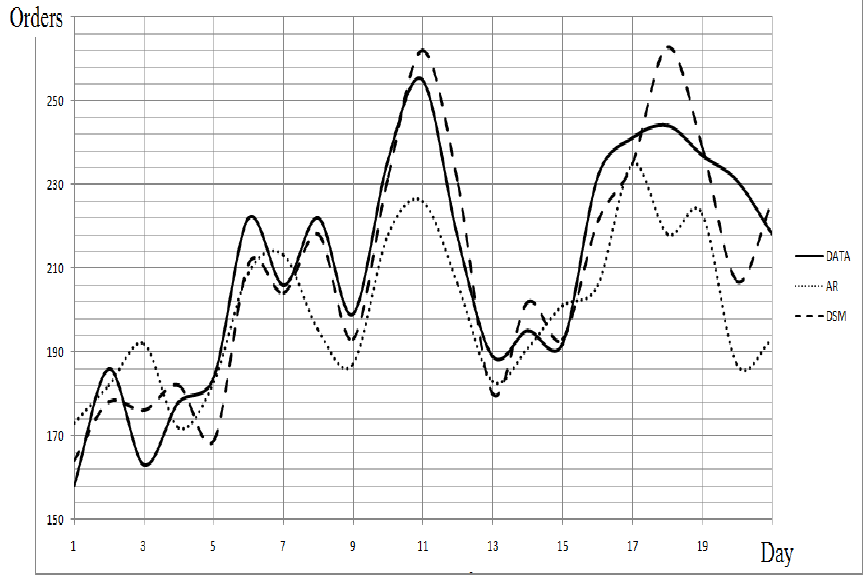
Fig. 2 Forecasting the number of taxi service orders by mathematical models of random